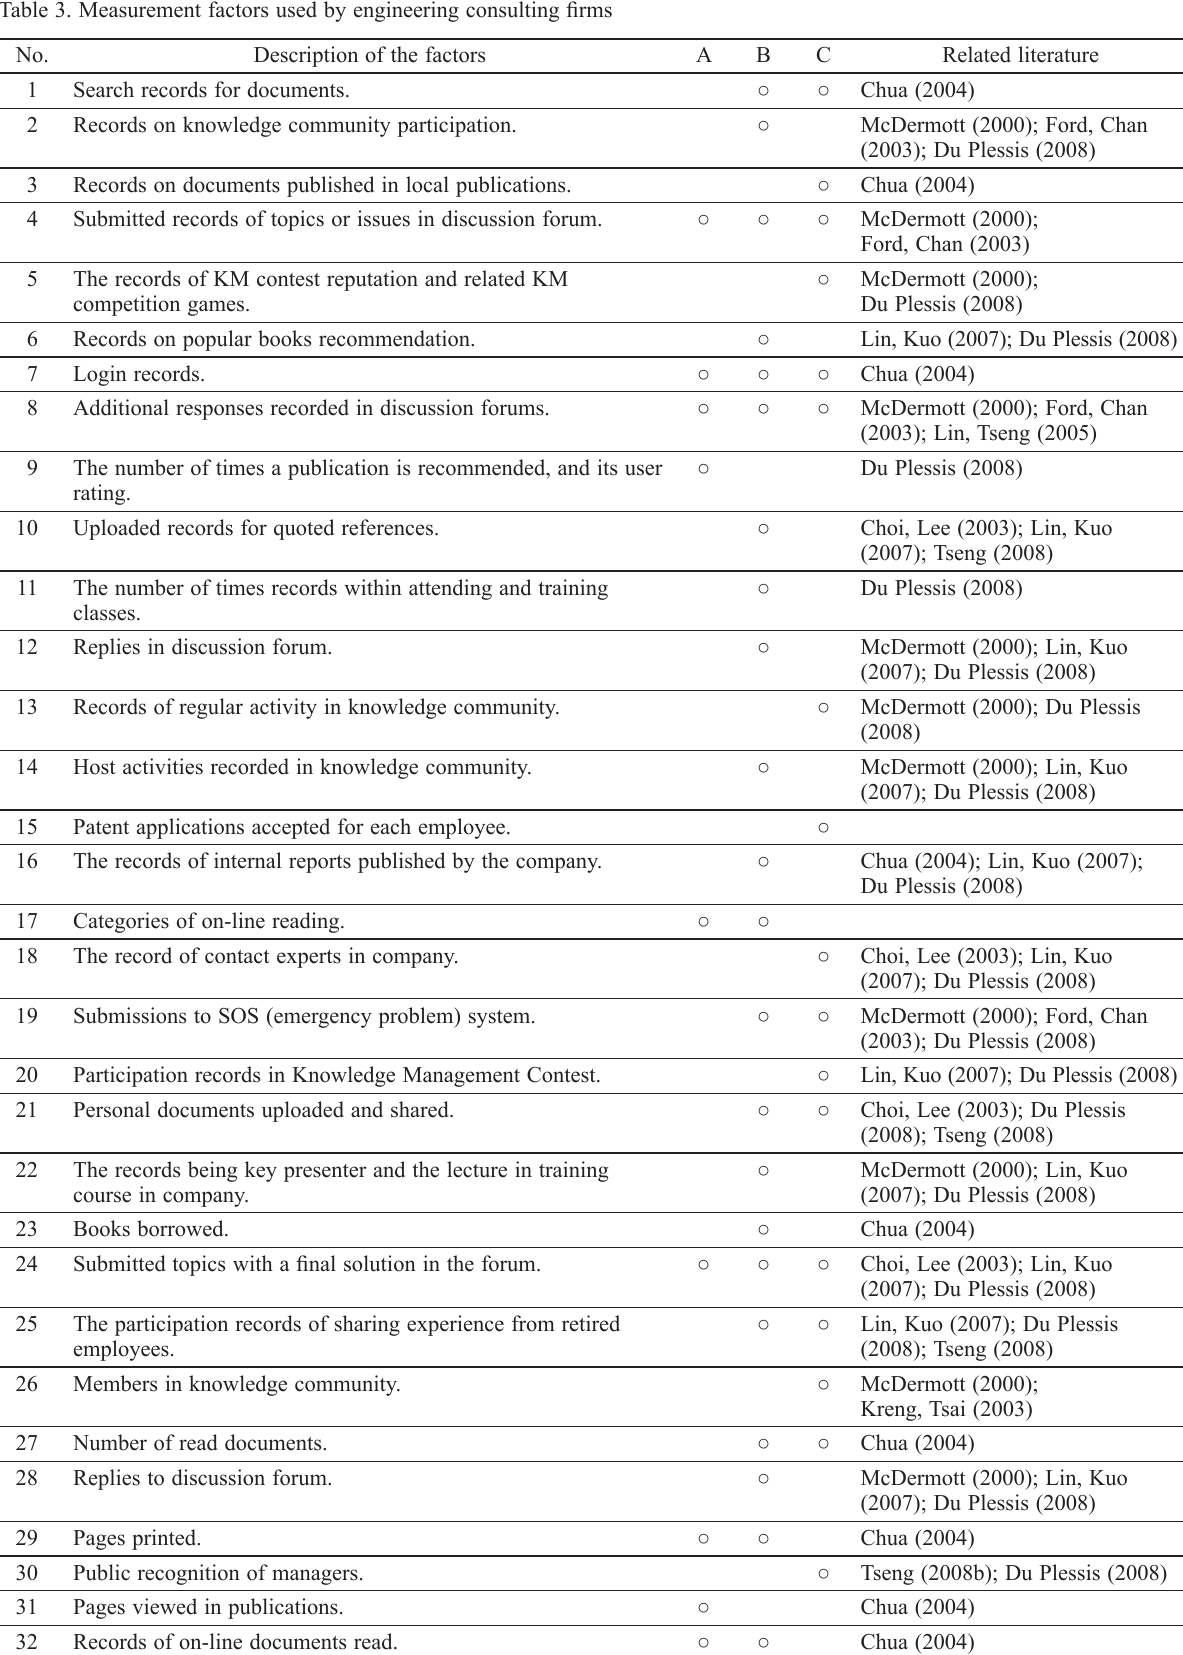
Table 3. Measurement factors used by engineering consulting firms No. Description of the factors Related